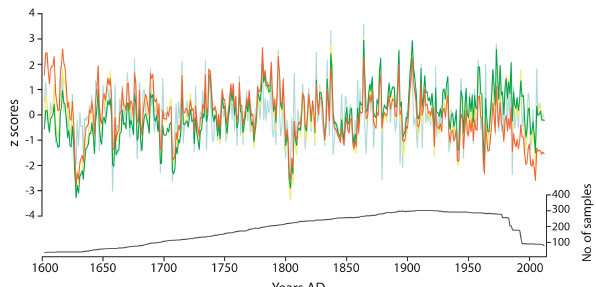
Figure 6. The four chronologies after different detrending methods for the EPS > 0.85 period; BasPois chronology (in orange), RCS chronology (in green), ArstanSTD chronology (in yellow), Arstan- RES chronology (in blue), and number of samples (in